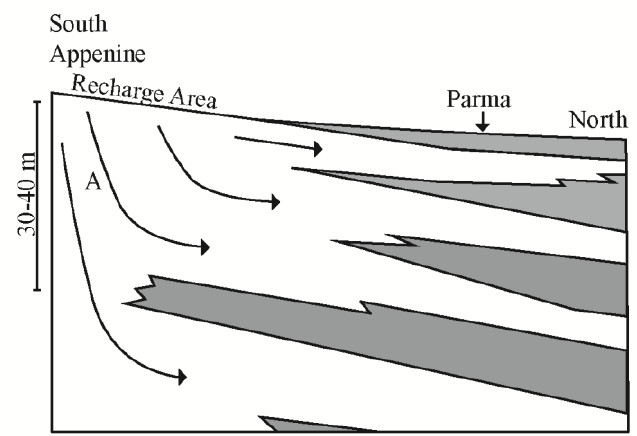
Figure 4. Aquifer system. Sketch view of the aquifer system from Apennines Mountains to Parma, modified from Nuova Carta Regionale della Vulnerabilità — aspetti metodologici (Direzione Ambiente e difesa del suolo e della costa, determinazione n. 6636 del 6/7/2001). In grey, the silt-clay layers; A identifies the main aquifer group.